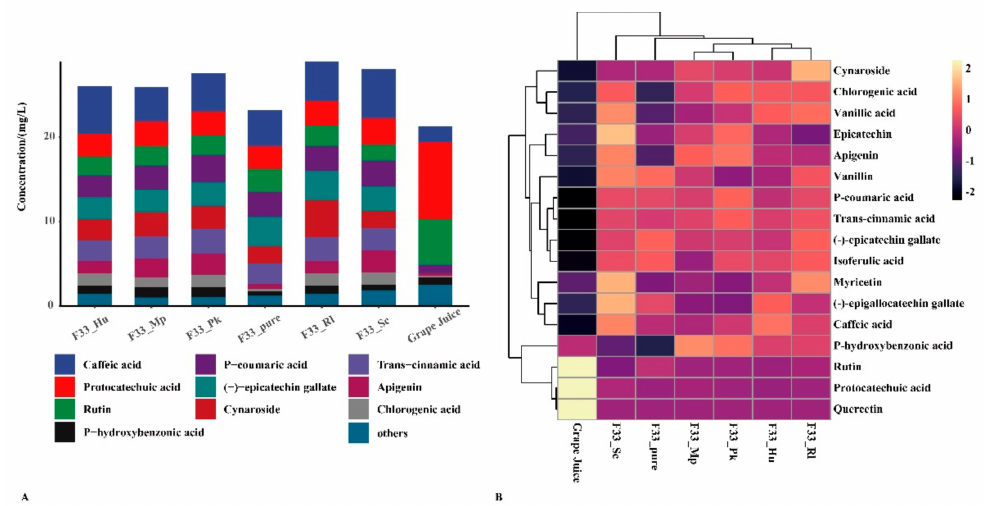
Figure 4. The distribution of polyphenols content under different fermentation strategies. ( A ) Stacked graph. ( B ) Clustering